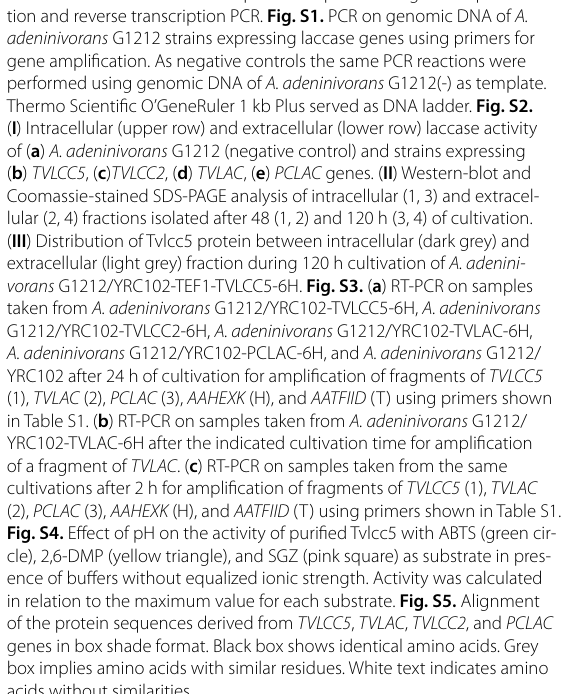
Fig. S4. Effect of pH on the activity of purified Tvlcc5 with ABTS (green cir- cle), 2,6-DMP (yellow triangle), and SGZ (pink square) as substrate in pres- ence of buffers without equalized ionic strength. Activity was calculated in relation to the maximum value for each substrate. Fig. S5. Alignment of the protein sequences derived from TVLCC5 , TVLAC , TVLCC2 , and PCLAC genes in box shade format. Black box shows identical amino acids. Grey box implies amino acids with similar residues. White text indicates amino acids without